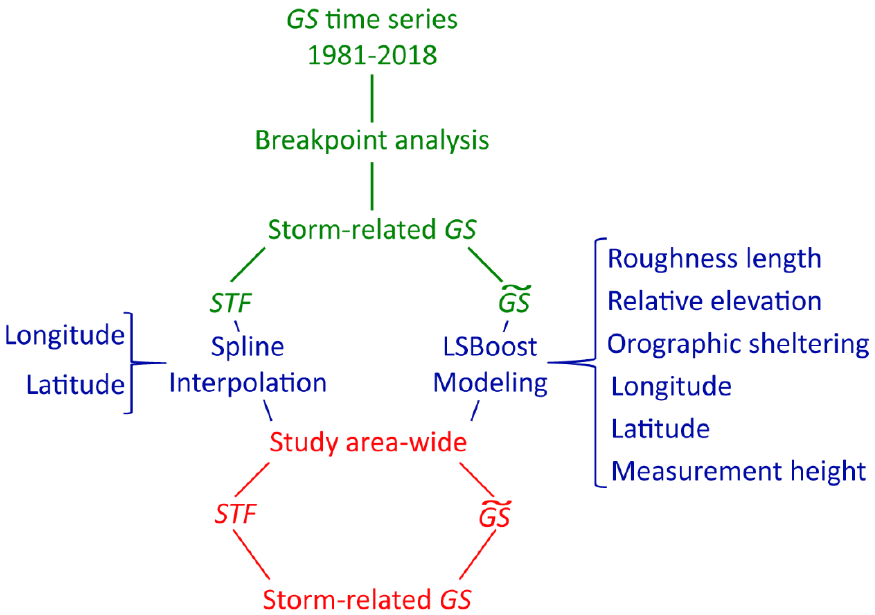
Figure 1. Overview of the methodology applied to develop Germany’s winter storm atlas (GeWiSA), with STF being the storm field factor, 𝐺𝑆 is the gust speed and 𝐺𝑆̃ is the median of 𝐺𝑆 .